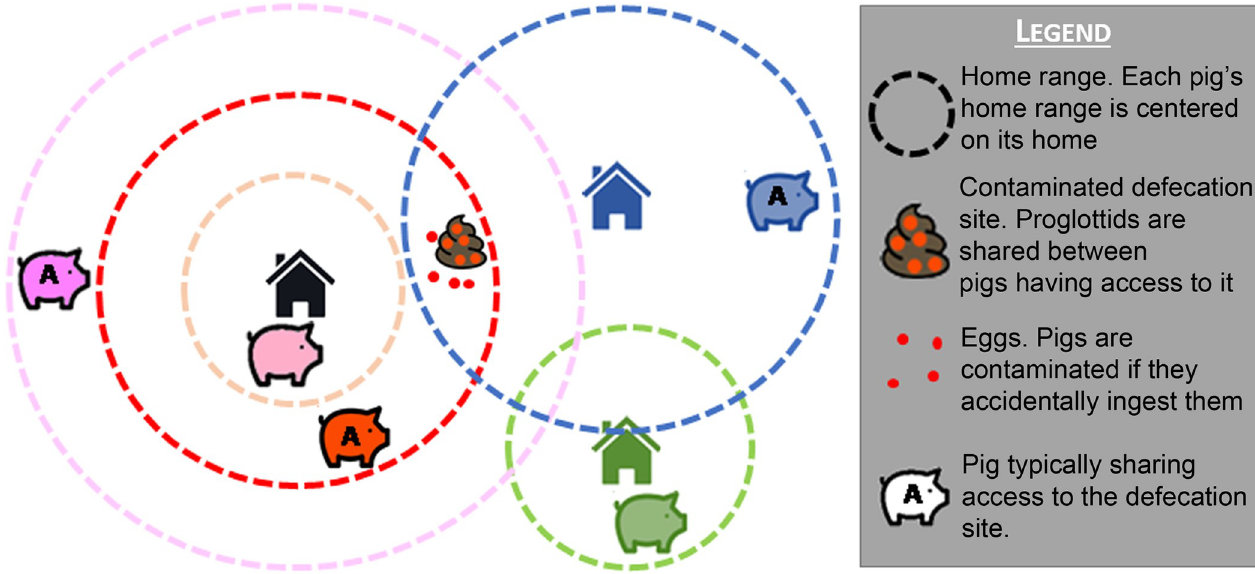
Fig 3. Estimation of contamination levels (pig module). The proglottids in the defecation site represented on the graph are typically shared between the pigs whose home range includes the site. The out-home range contamination term accounts for the occasional wandering of other pigs near the site. Disseminated eggs can be seen at the defecation